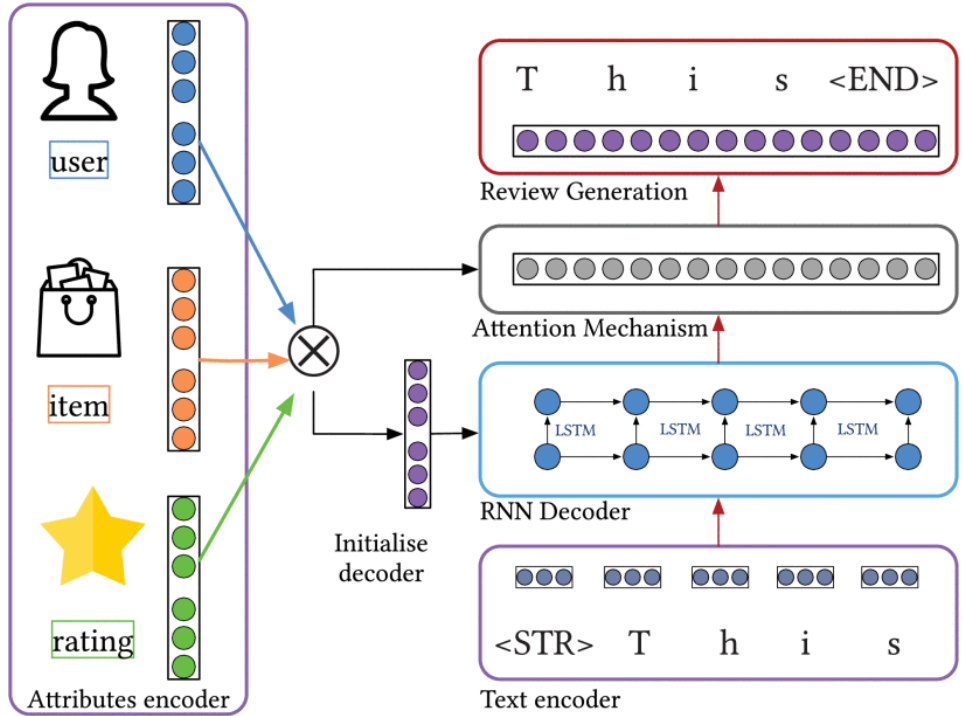
Figure 6. NLP-based